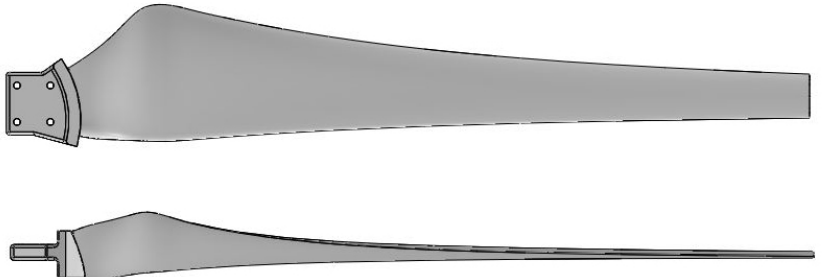
Figure 3. Originally designed FX geometry, front (upper) and side views.